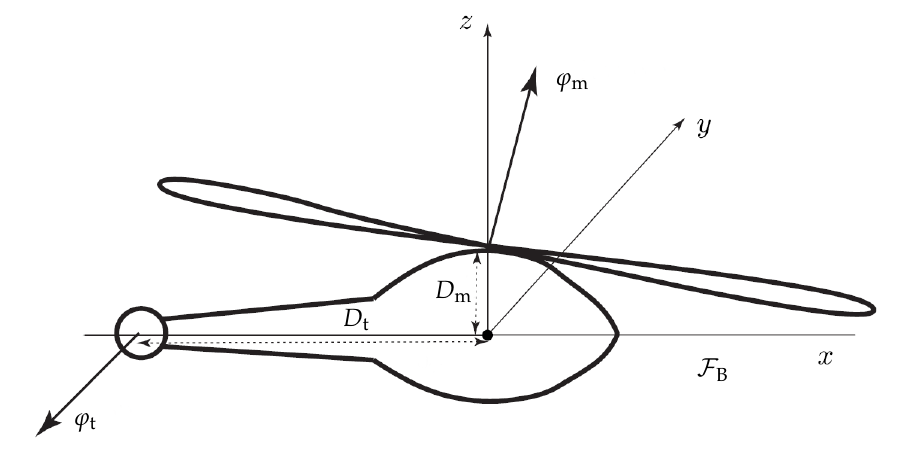
Figure 5. Schematic of a helicopter with a principal rotor and a tail rotor (adapted from [12]). (The principal rotor to center of mass distance D m and the tail rotor to center of mass distance D t are expressed in meters